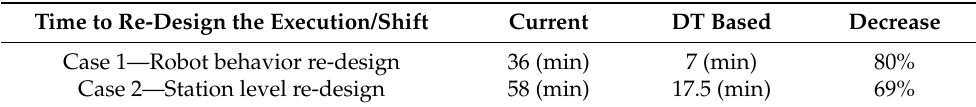
Table 3. Comparison of the two systems—responsiveness to disturbances.